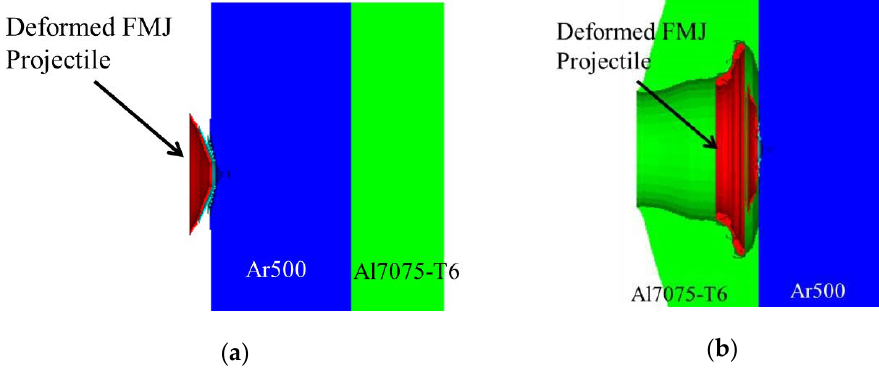
Figure 13. Penetration of FMJ projectile at 0.07 ms and initial velocity of 800 m/s for: ( a ) Configuration A; and ( b ) Configuration B.